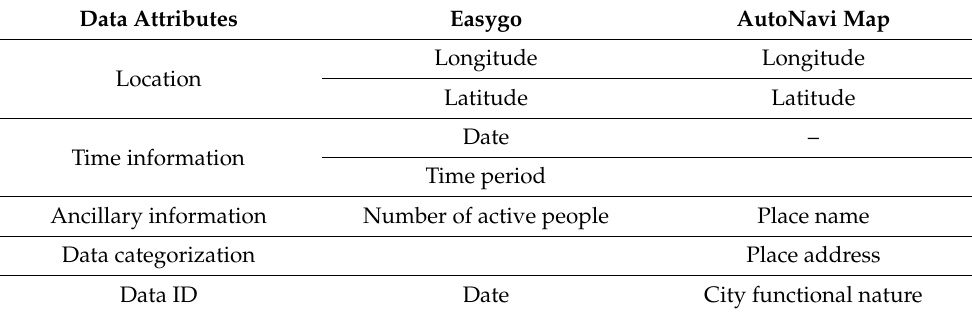
Table 3. The specific metadata of the obtained original